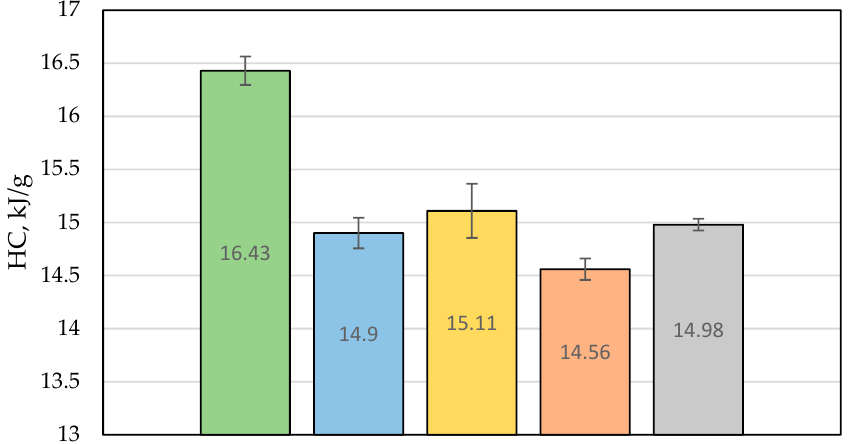
Figure 7. The average heat of combustion (HC, in kJ/g) for the untreated wood and samples coated with starch ‐ based formulations.